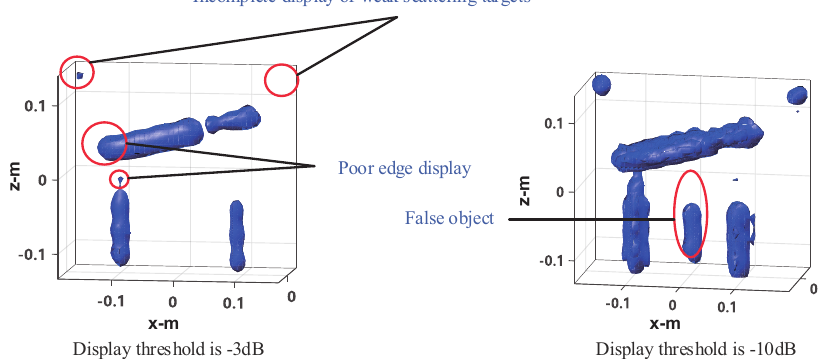
Figure 15. Imaging results of the frequency interpolation method with different display threshold.